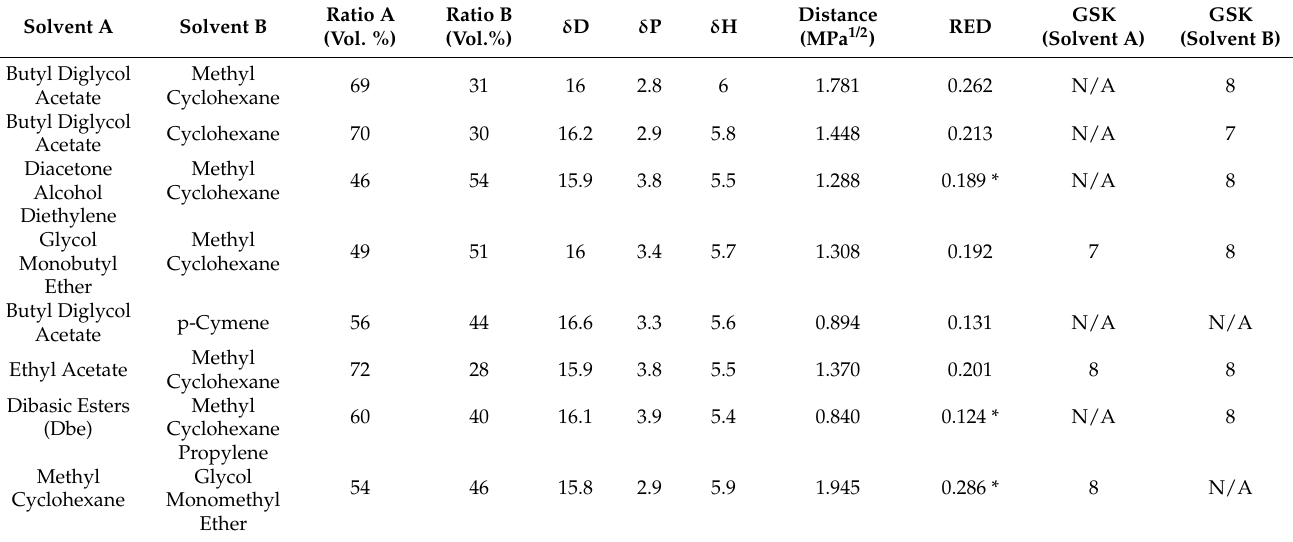
Table 4. Safer solvents optimized from this study for replacing dichloromethane (DCM) in removing conformal coatings. Solvent A Solvent